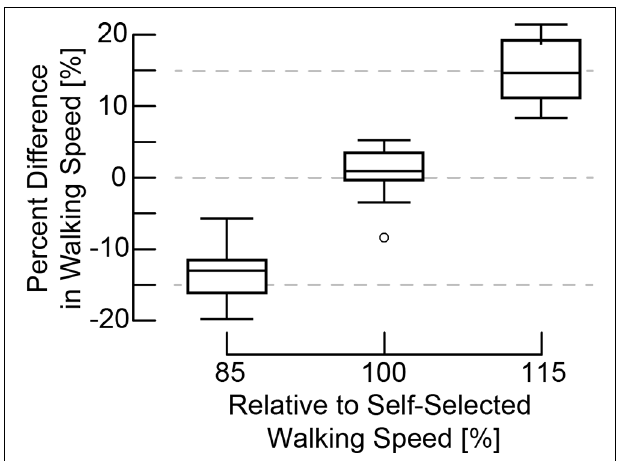
FIGURE 3 | Percent difference in walking speed: actual vs. target. A one-sample Wilcoxon signed-rank test found that actual walking speeds of the participants did not differ from the expected speeds during the SS 85 (median difference from baseline: − 13.8%, z = 0.63, p = 0.53), SS 100 (median difference from 1.2%, z = 1.23, p = 0.23), and SS 115 (median difference: 14.2%, z = 0.16, p = 0.88) conditions.